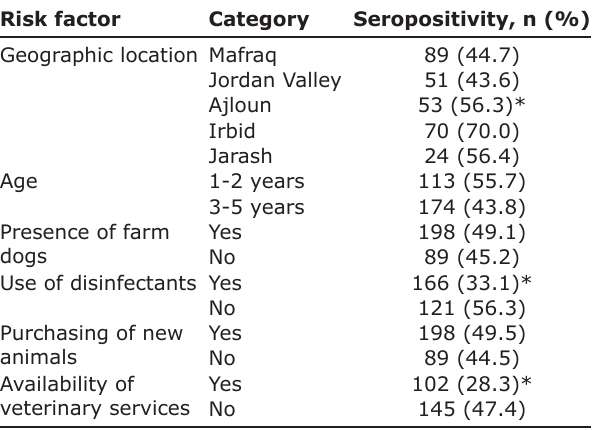
Table-1: Univariate analysis of risk factors associated with high seropositivity of bluetongue virus group-specific antibodies in sheep (n=600).